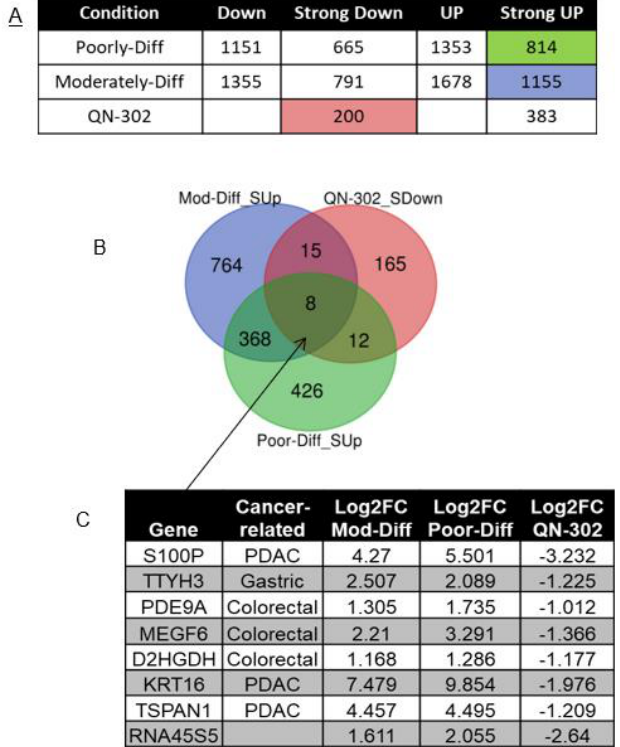
poorly differentiated PDAC.